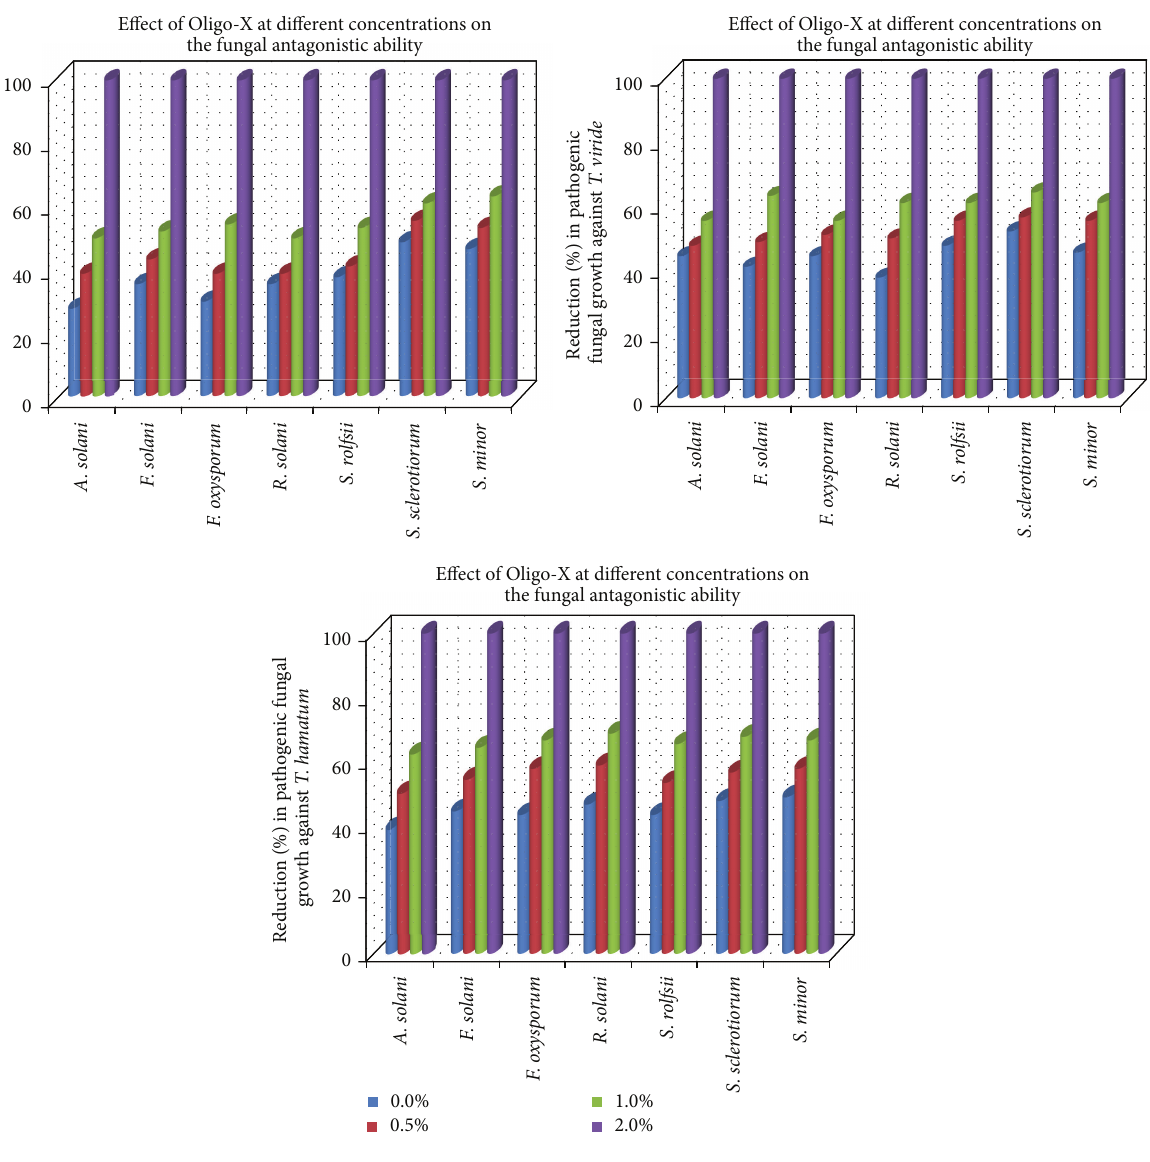
Figure 2: Reduction (%) in pathogenic fungal growth against Trichoderma spp. in medium supplemented with Oligo-X at different concen- trations in vitro